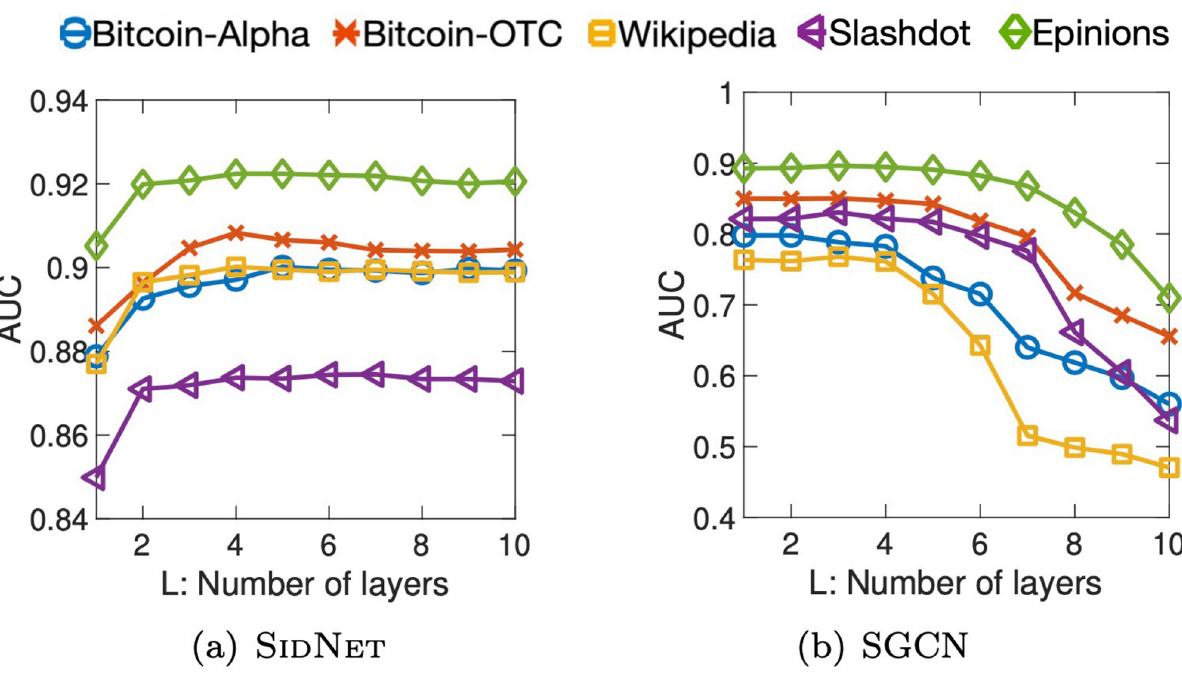
Fig 4. Effect of the number L of layers of S ID N ET compared to the state-of-the-art SGCN. The accuracy of S ID N ET increases and becomes stable while that of SGCN dramatically degrades as L increases.